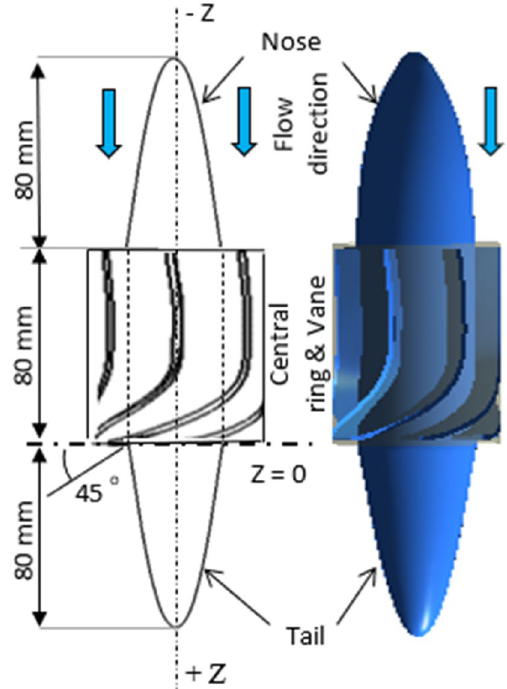
Fig. 3: 45° vane angle created with respect to the horizontal axis (left) and modeled swirler